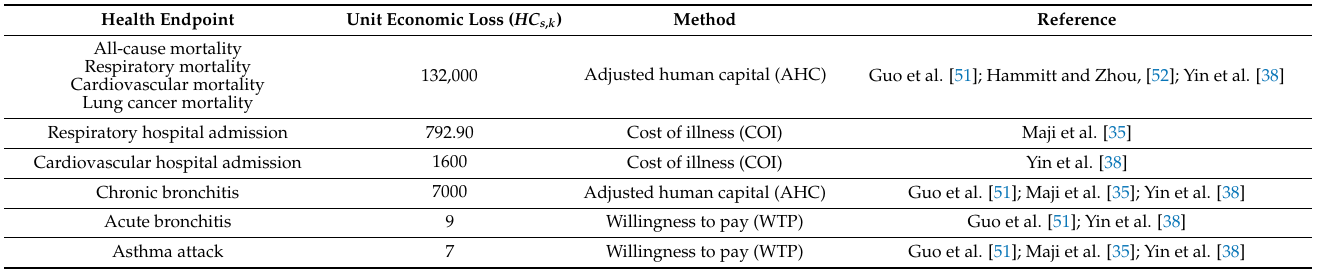
Table 3. Unit economic loss of each health endpoint in China in the base year